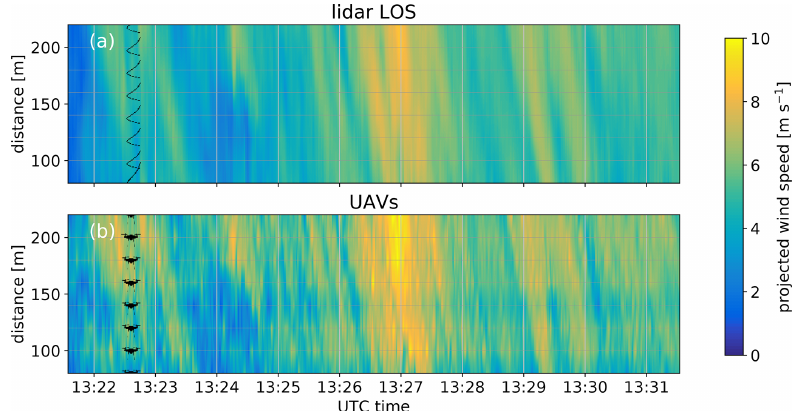
Figure 10. Time series of spatial wind measurements with a lidar (a) and eight drone (b) along a lidar line of sight. The y -axis grid represents the location of the range gate centers of the lidar and the drones respectively.